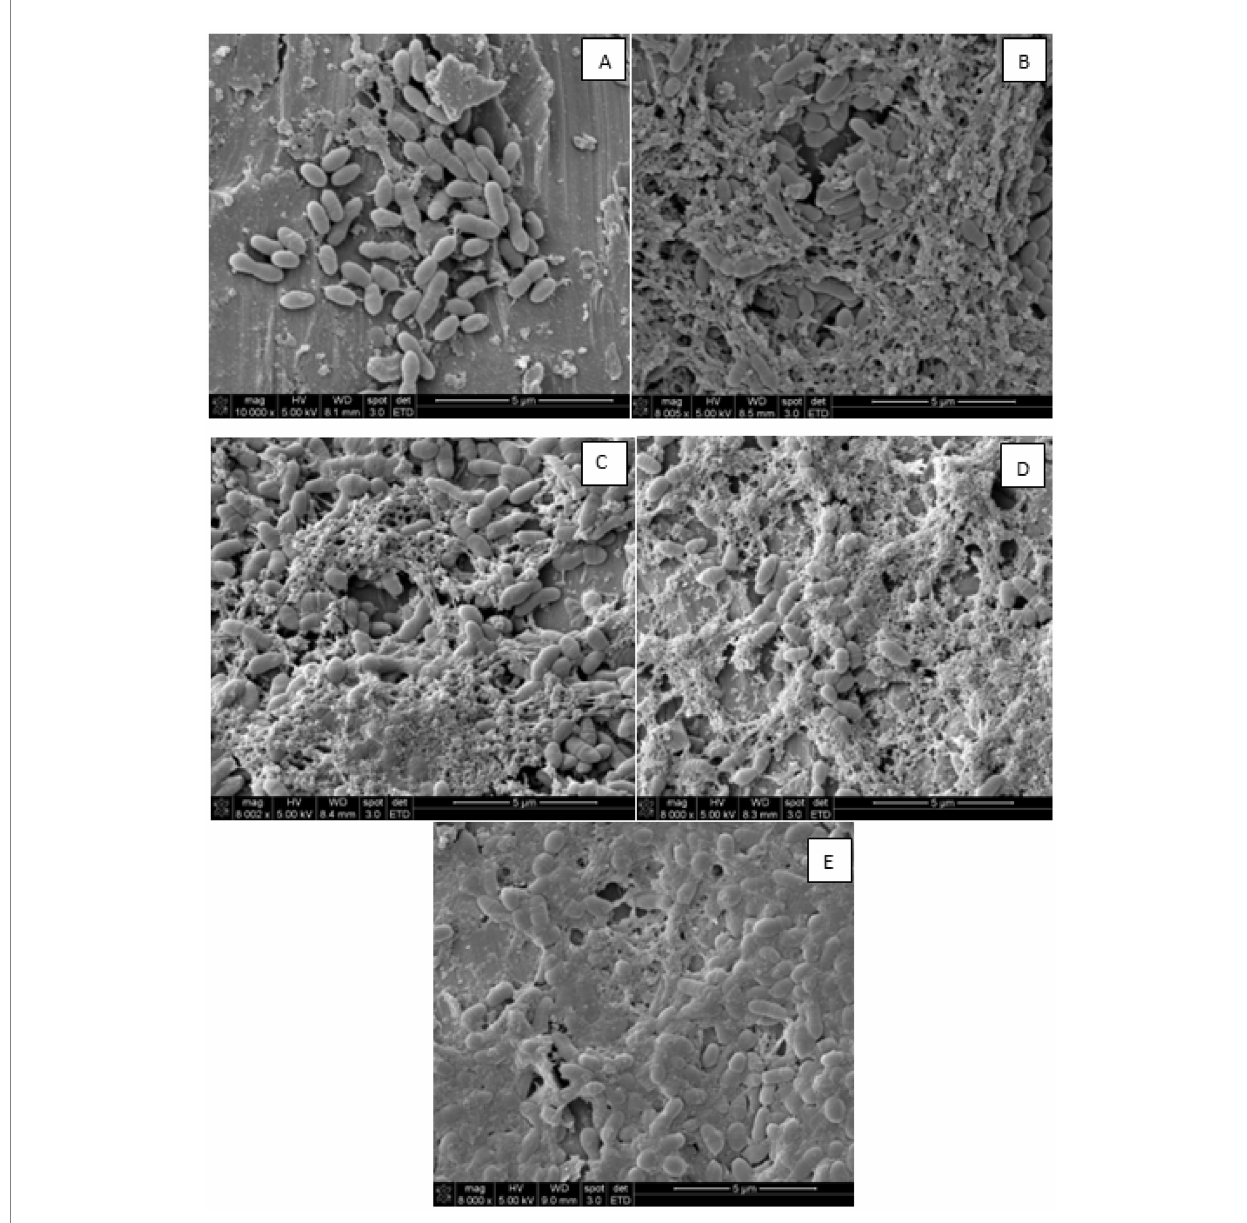
FIGURE 4 Scanning electron micrographs showing Pseudomonas fluorescens ATCC 25289 biofilm structure on stainless steel surface after 2-day stagnant incubation (A) , and after one-day circulation (B) , three-days circulation (C) , four-days circulation (D) , and five-days circulation (E) at 1.5–2.0 L/h and simultaneous feeding with 10% diluted skim milk at 125